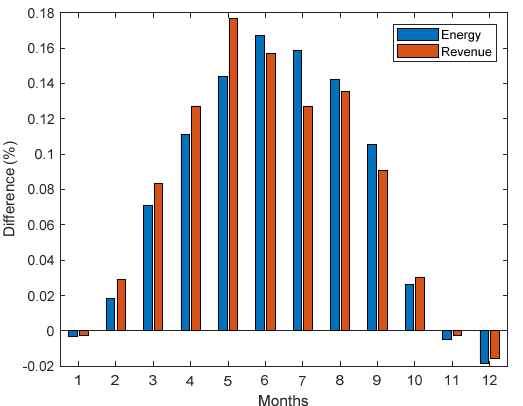
Figure 12. The difference of the converted electric power and revenue between the reference inverter and DSPI digital twin for a 1 year period.